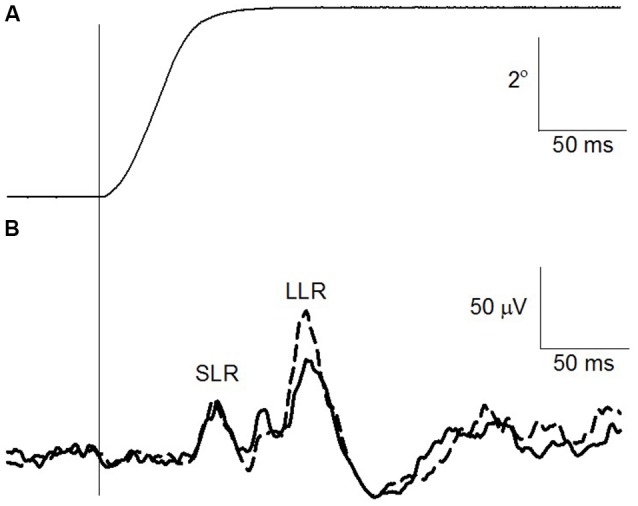
Change in TA stretch reflex after suprathreshold PAbi-PAS at rest. (A) Right ankle angle (°). The vertical line indicates the onset of the imposed plantarflexion perturbation. (B) TA rectified electromyographic (EMG) trace prior to (solid line) and following (dashed line) the suprathreshold PAbi-PAS intervention. Data are the average for 30 traces.